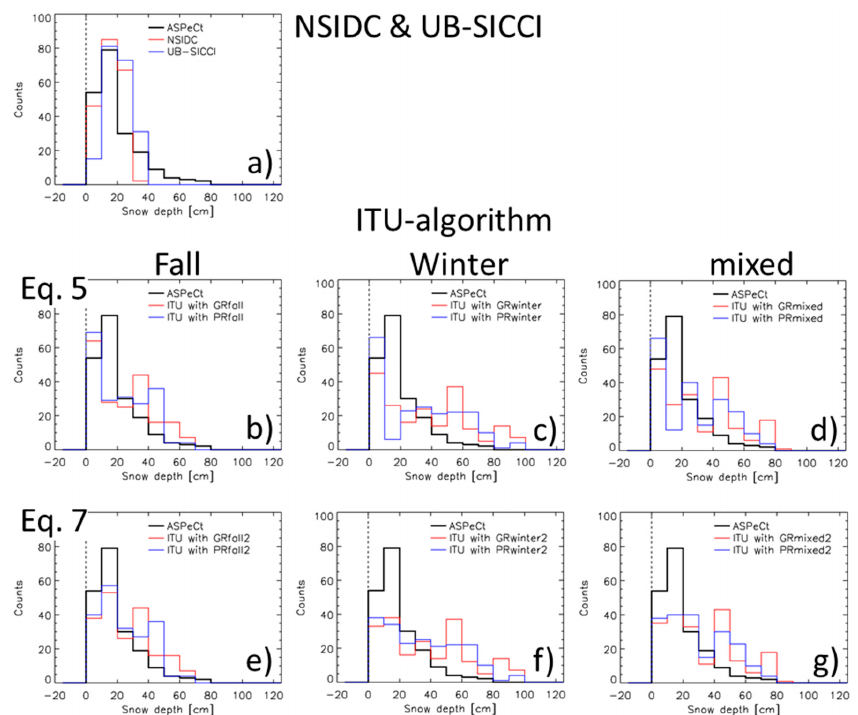
Figure 8. The histograms of the co-located daily mean along-ship track snow depths computed from the AMSR-E/AMSR2 data of the years 2002–2015 for sea-ice concentrations > 90% and 2m-air temperatures < − 10 °C. The bin size is 10 cm. The ASPeCt data are shown in black in all panels. ( a ) NSIDC and UB-SICCI; ( b – d ) ITU PR06 and GR1006HV using Equation (5); ( e – g ) ITU PR06 and GR1006HV using Equation (7). See text for more details. Table 3. The mean, standard deviation of the mean (sdev) and median difference of the ASPeCt minus AMSR-E/AMSR2 (AMSRX) snow depth, and the squared correlation of a linear regression “R 2 ”. All quantities except R 2 are given in centimeters. See Figure 8 and text for more details.